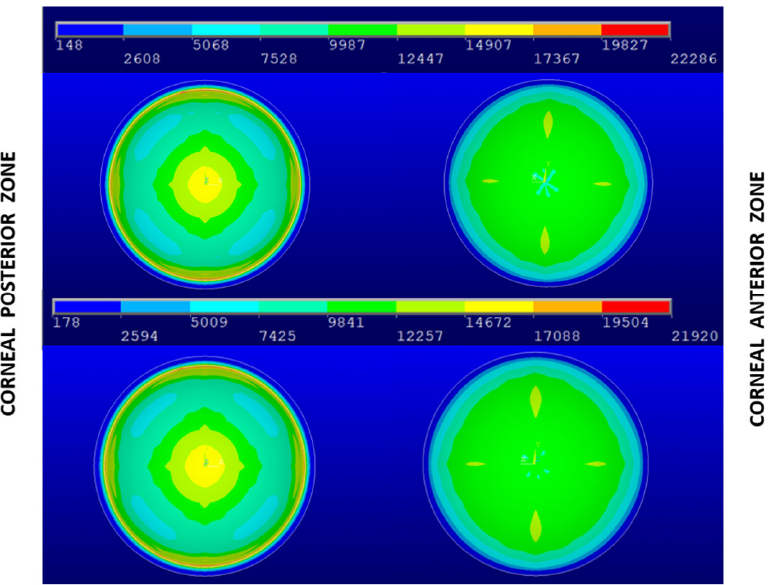
Figure 4. Stress distribution in measurement phase for Navarro’s Geometry. Displacement method ( Upper ), prestress method ( Lower ).